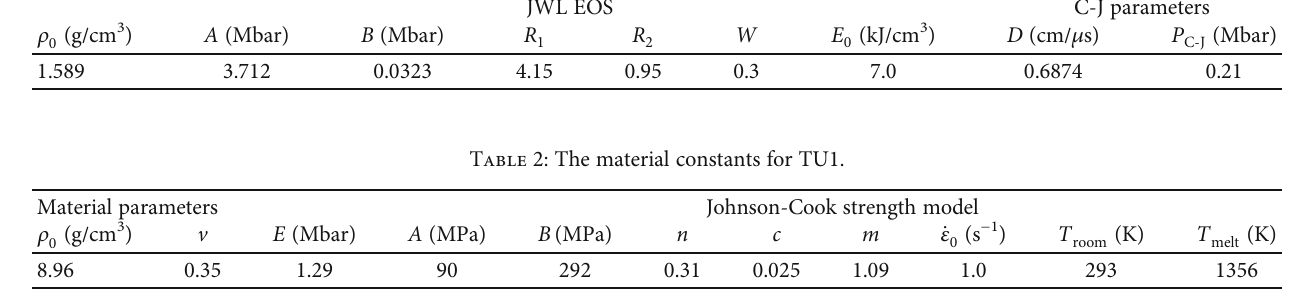
Table 1. For the copper TU1, the Johnson-Cook strength